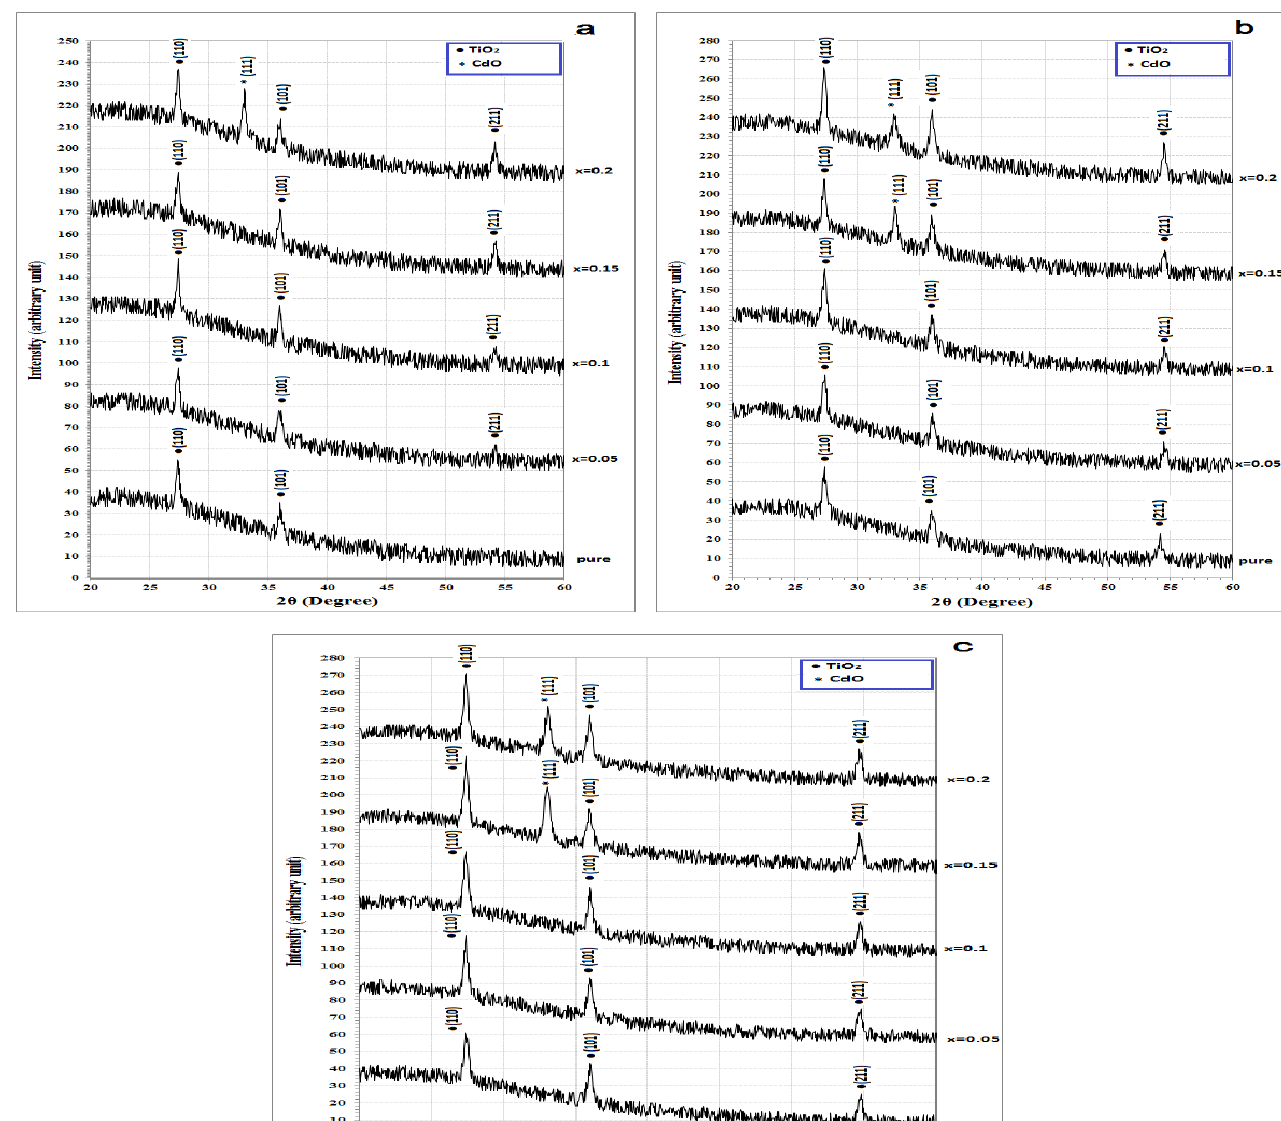
Fig. 2: The X-Ray diffraction for TiO